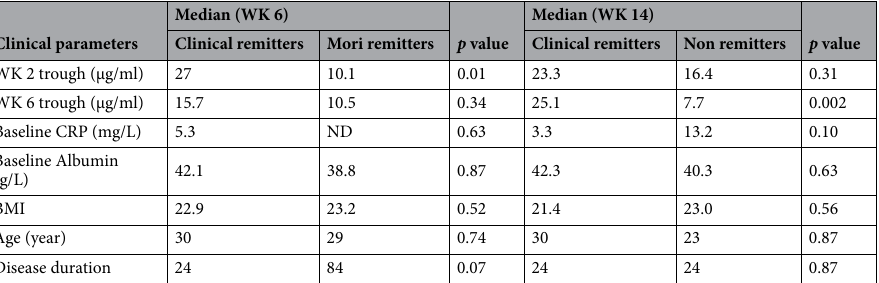
Table 5. Week 6 Clinical parameters univariate analysis association with week 14 clinical remission. CRP C reactive proteins, IBD Inflammatory bowel disease, ND Not determined.